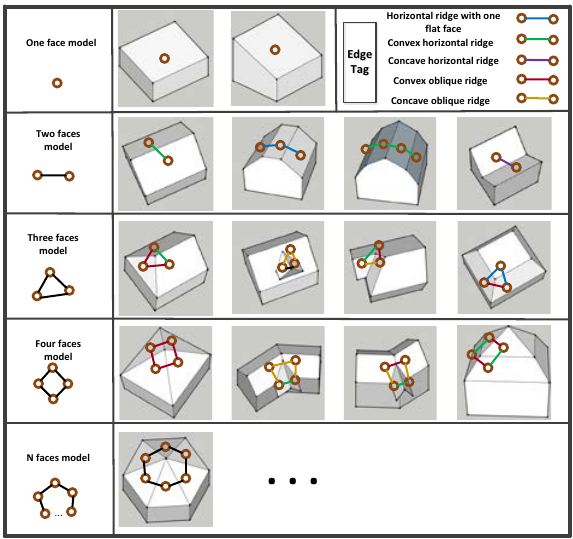
according to the number of nodes. In the first column, circles (graph node) present roof patches and lines (graph edge) denote the intersection line. Colours of graph edge present different edge attributes. Black line means the attribute is